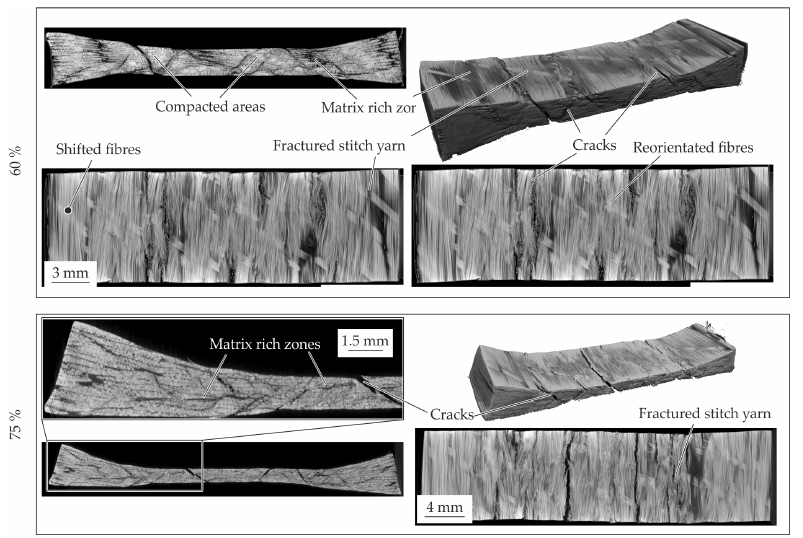
Figure 16. CT analysis of the 4mm—configuration for the different compaction levels at 180°C.